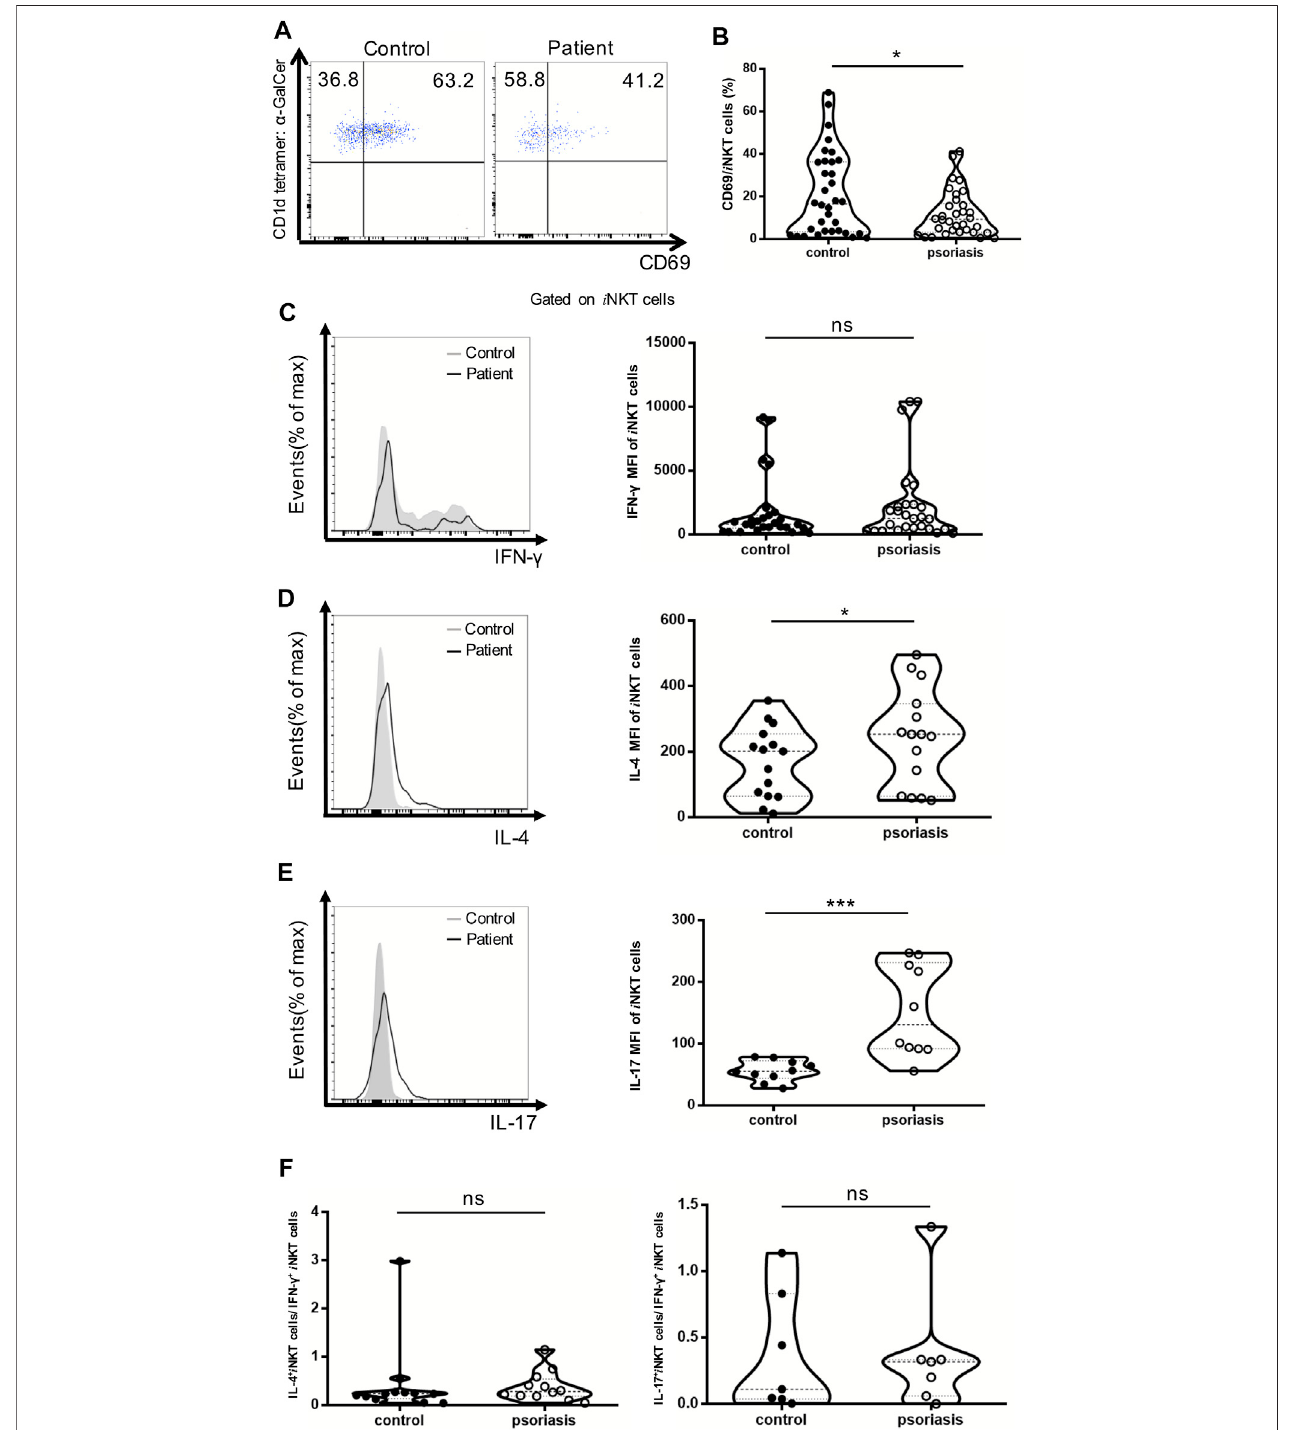
FIGURE4| i NKTcellsactivationstatusandcytokineproductioninPBMCsofpsoriasispatients.IntracellularIFN- γ andIL-4productionofcirculating i NKTcellswas analyzed after stimulation with Cell Stimulation Cocktail for 5 h. (A) Representative FACS dot plots for iNKT cell CD69 expression in psoriasis patients and healthy controls. (B) Summary plots showing individual results of the frequency of CD69 + iNKT cells in psoriasis patients versus healthy controls. (C) Representative histogram and summary plots showing individual results of the MFI of IFN- γ -producing iNKT cells in psoriasis patients versus healthy controls. (D) Representative